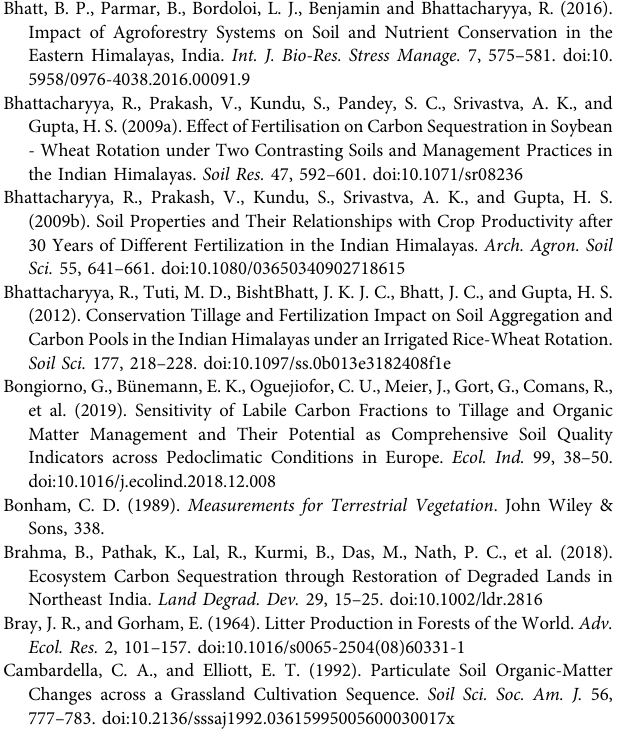
Supplementary Figure S1 | Representative fi gures of hedge (A) , alder (B) and guava (C) agroforestry systems and compared with maize-mustard-potato (D) cropping system under sub-Indian Himalayas. Supplementary Figure S2 | Effects of various agroforestry systems on soil organic carbon stocks (SOC stocks) in the different soil depths (0-10, 10-20 and 20-30 cm) of the Indian sub-Himalayas. (Means of different land use systems within a column followed by similar lowercaseletters arenot signi fi cantat p < 0.05based onTukey ’ s HSD test.) Supplementary Figure S3 | Effect of various agroforestry systems on C:N in the Indiansub-Himalayas.(Meansofdifferentlandusesystemswithinacolumnfollowed by similar lowercase letters are not signi fi cant at p < 0.05 based on Tukey ’ s HSD